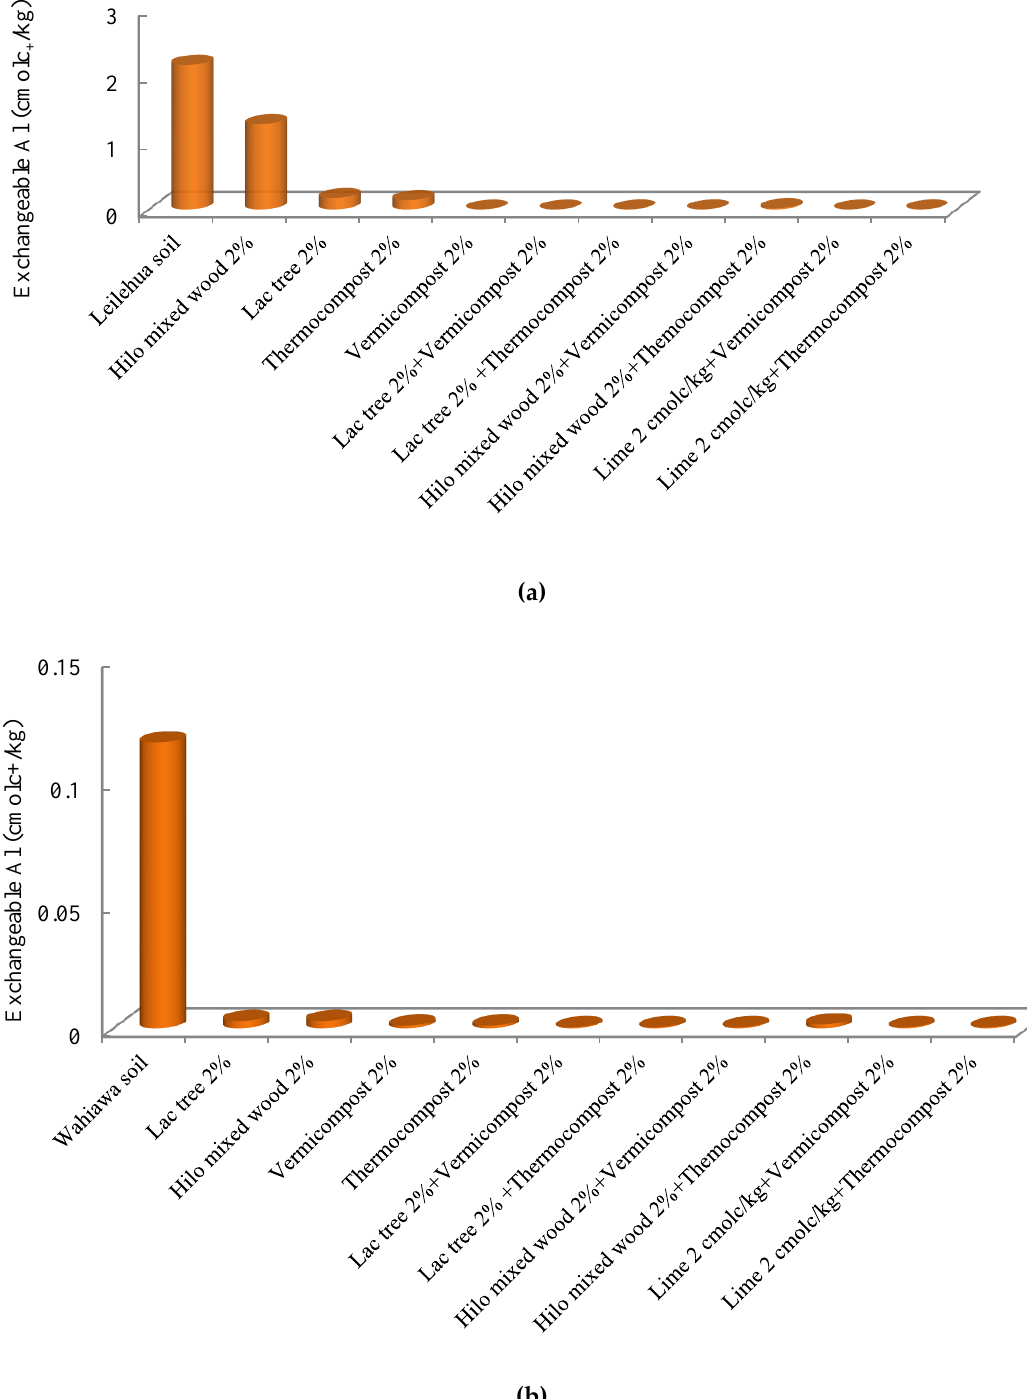
Figure 1. Exchangeable Al in the Leilehua Ultisol ( a ) and Wahiawa Oxisol ( b ) as affected by biochar, lime and/or compost additions.